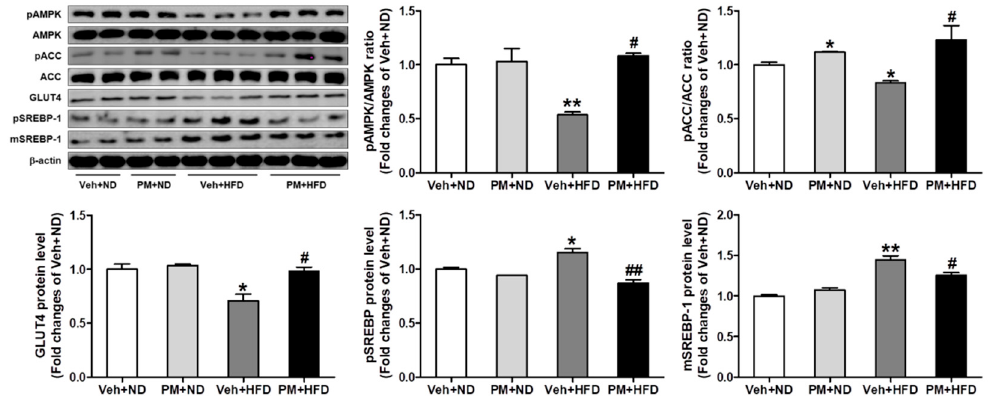
Figure 7. The effect of PM extract on AMPK and ACC phosphorylation, GLUT4, and SREBP-1 protein levels in the liver tissues of ND- or HFD-fed mice. Representative images of western blot analysis are shown, and densitometric quantifications of relative band intensities are presented. The mice fed with ND or HFD were treated with PM extract or vehicle for 16 weeks, and the liver tissues were collected. Data are the mean ± SEM. * p < 0.05 and ** p < 0.01 vs. Veh + ND group; # p < 0.05 and ## p < 0.01 vs. Veh + HFD group.